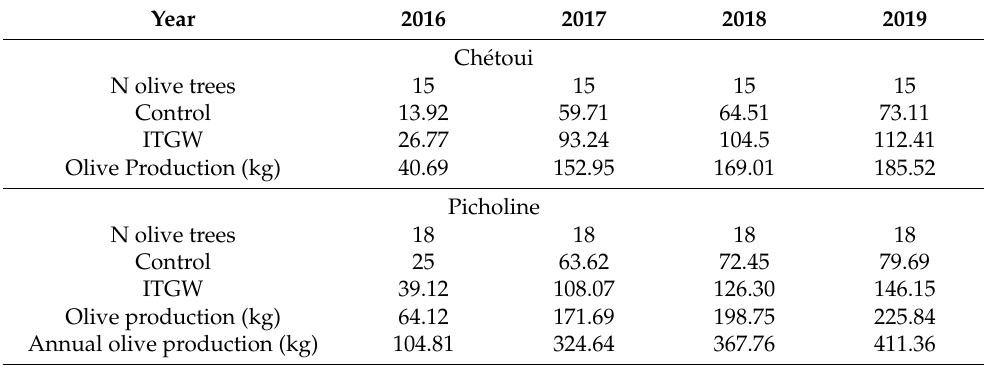
Table 4. Average olive production of two varieties, Chétoui and Picholine, under irrigation with TGW.